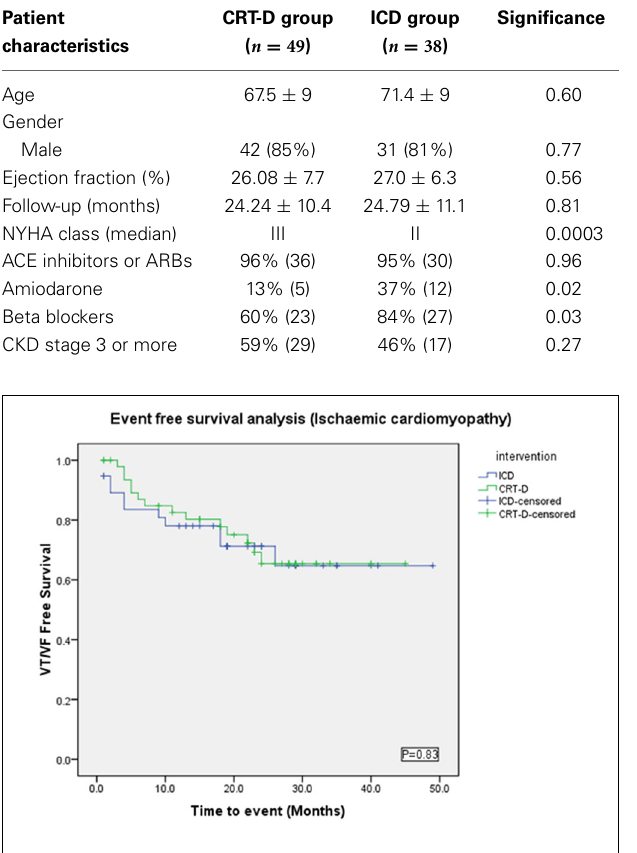
FIGURE 6 | Kaplan Meyer survival analysis of the occurrence of VT/VF between ICD and CRT-D groups in the ischemic cardiomyopathy patient cohort.